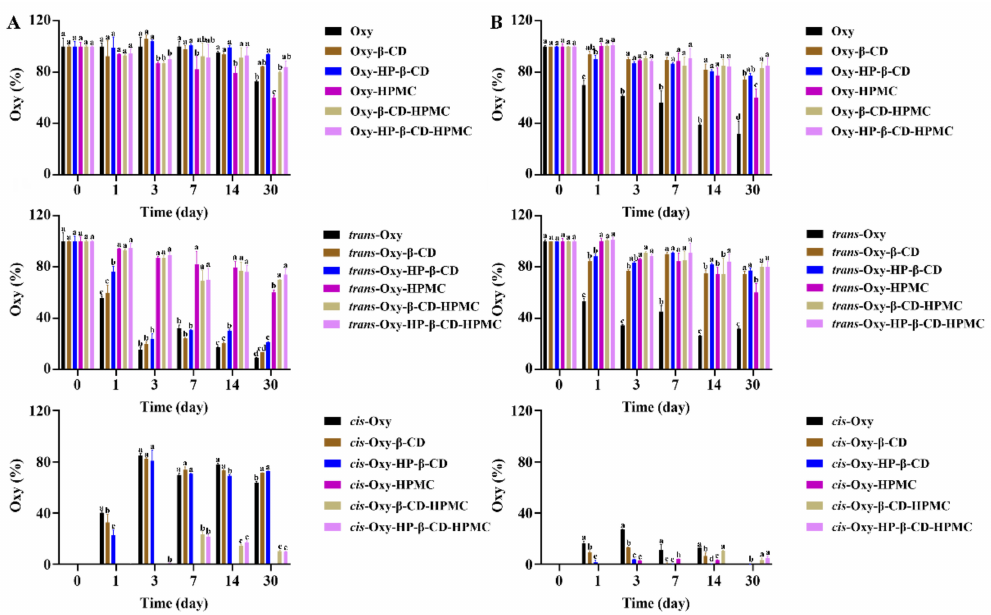
Figure 6. The percentage of remaining Oxy (both trans - and cis -forms) in Oxy, Oxy–HPMC, Oxy– CD, and Oxy–CD–HPMC solutions during 30 days of storage at 25 ◦ C with light was recorded by monitoring Oxy content with HPLC at a certain time interval ( n = 3, if no error bars are displayed, errors were smaller than symbols). Data were presented as mean ± SD, and significant differences compared to the pure Oxy group are shown with lower case letters a–d. All samples were stored in well-closed glass bottles. ( A ) Water; ( B ) acidic solution (pH